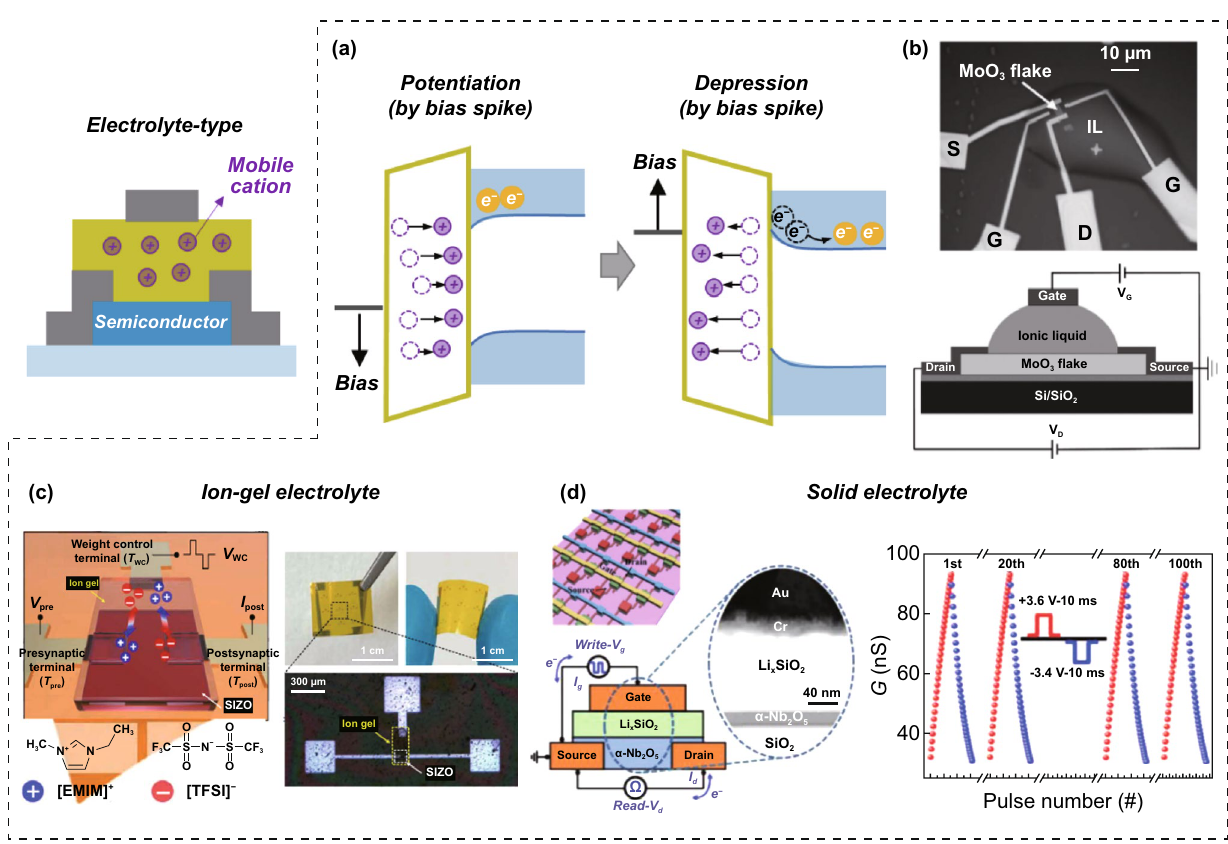
Fig. 4 Electrolyte transistor‑type ES; a operation mechanism, b ionic liquid electrolyte‑based transistor‑type ES, c ion‑gel electrolyte‑based transistor‑type ES, and d inorganic solid electrolyte‑based transistor‑type ES. b Reproduced with permission [19]. Copyright @ 2017, Wiley‑ VCH. c Reproduced with permission from Ref. [20]. Copyright @ 2021, AAAS. d Reproduced with permission from Ref. [27]. Copyright @ 2020,